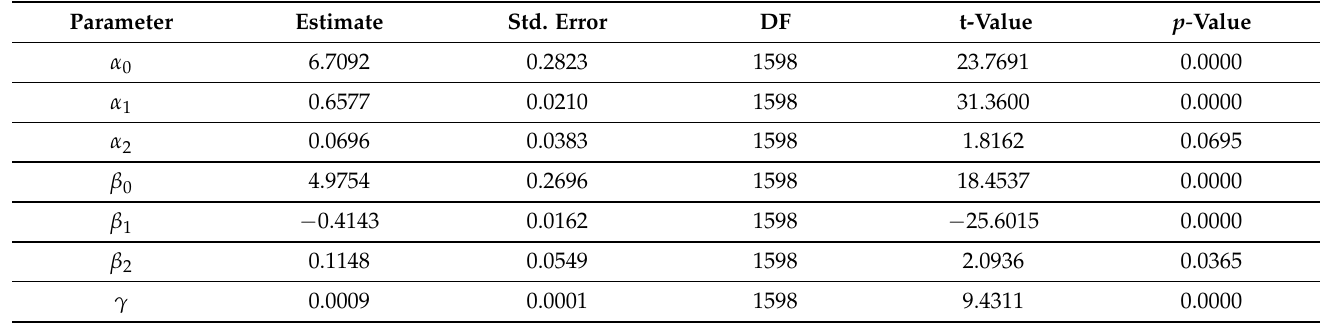
Table 5. The estimates for the fixed parameters of model M 9 .